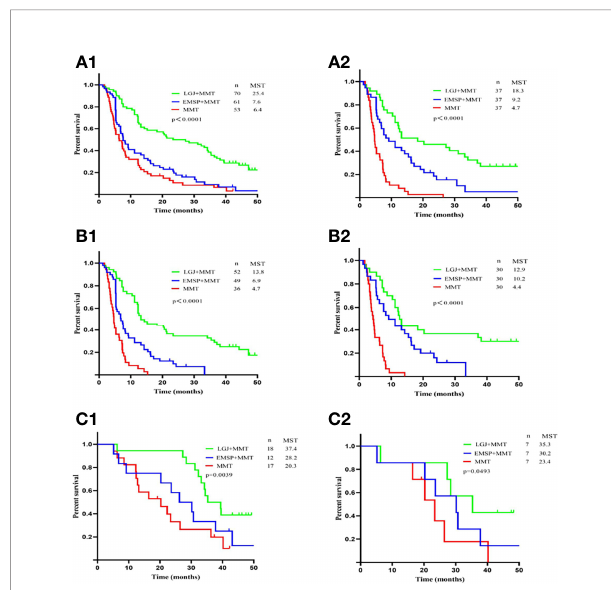
FIGURE 1 | Overall survival according to treatment models. (A1) OS for patients treated by NAC and conversion therapy. (A2) OS for patients treated by NAC and conversion therapy after propensity score matching. (B1) OS for patients treated by conversion therapy. (B2) OS for patients treated by conversion therapy after propensity score matching. (C1) OS for patients treated by NAC therapy. (C2) OS for patients treated by NAC therapy after propensity score